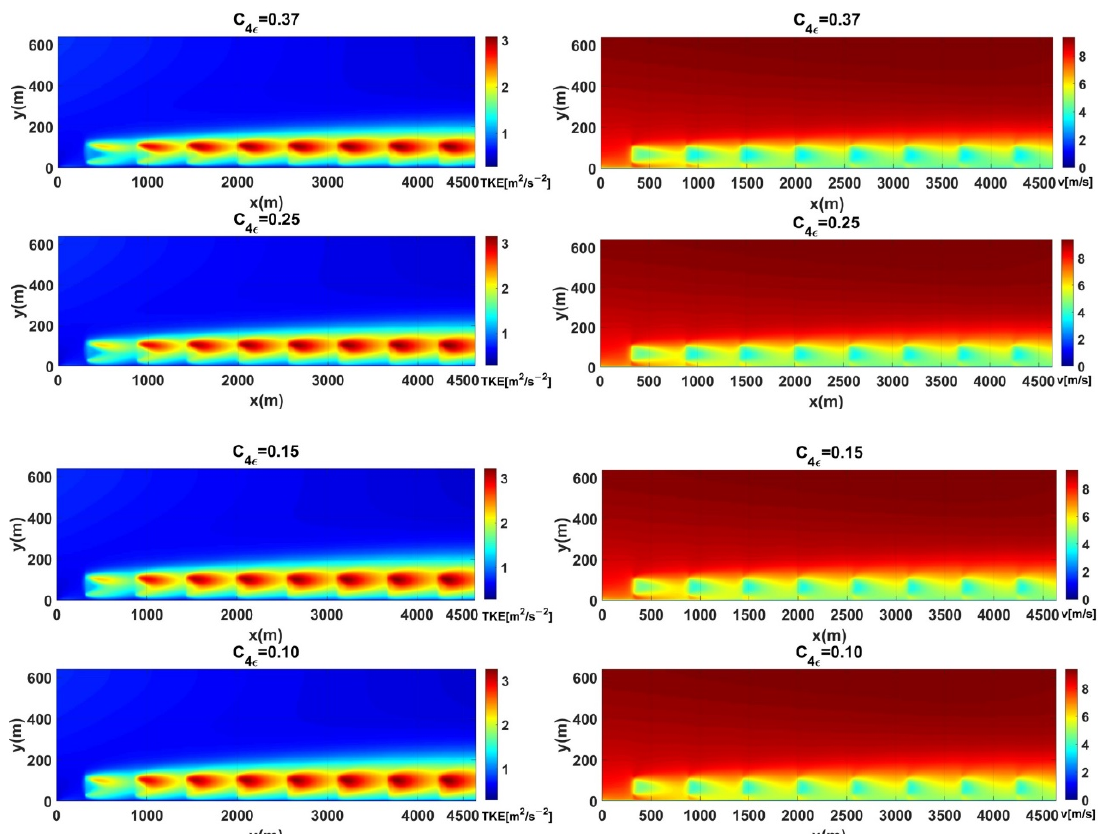
Figure 12. Comparison of contours involving TKE and streamwise wind speed for different C 4 ε in the vertical direction when the incoming wind direction is 270°.